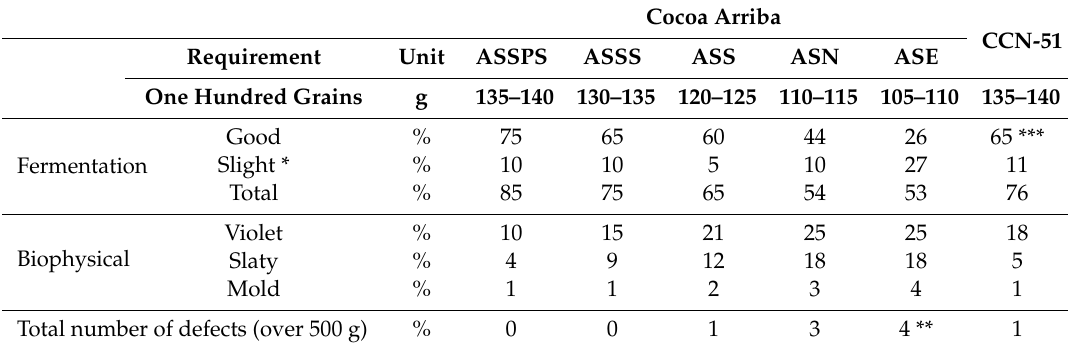
Table 1. Standards of Cacao Arriba Protected Designations of Origin (PDO) and CCN-51.